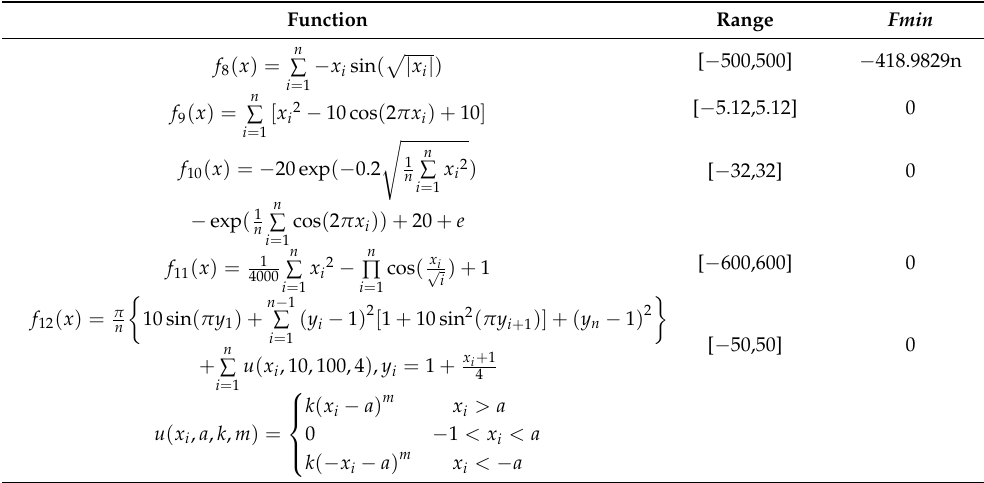
Table 3. Five high-dimensional multi-objective test functions (Dim =